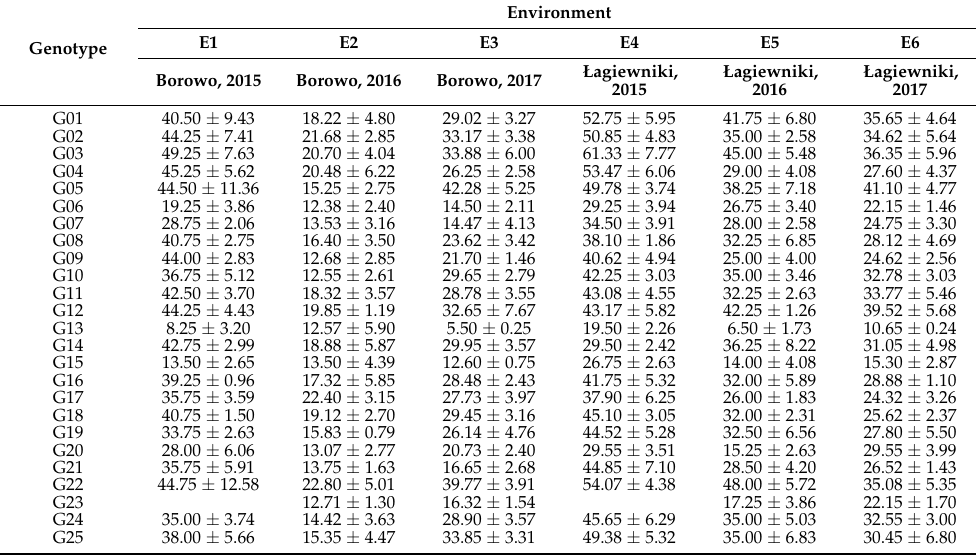
Table 9. Mean values ± standard deviations (s.d.) for seed yield of winter oilseed rape genotypes in particular